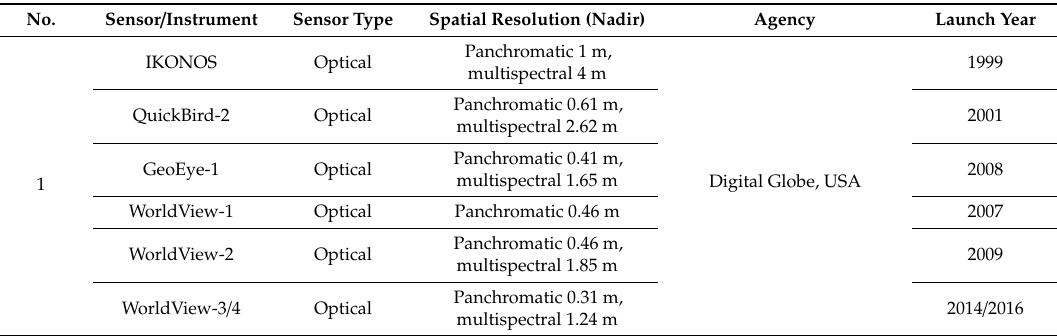
Table 2. Submeter commercial satellites (1 m or higher